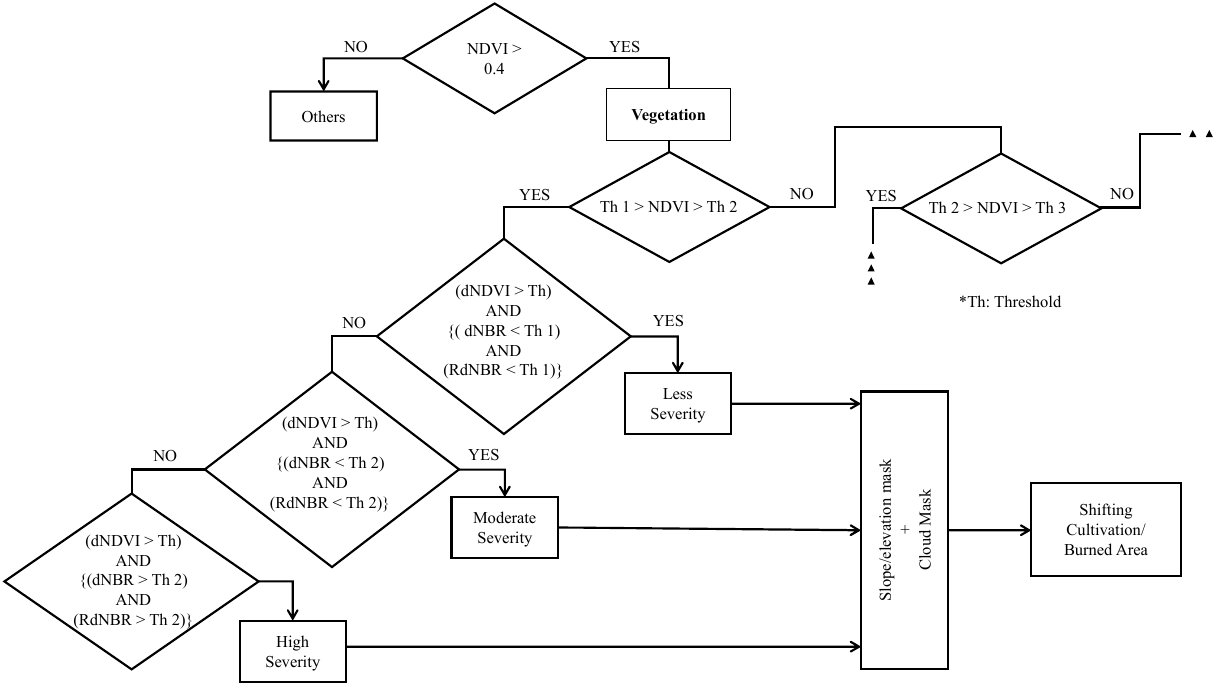
Figure 4. Conceptual diagram of the decision tree-based multi-step threshold (DTMT) methodology adopted for mapping of shifting cultivation areas in NE India .